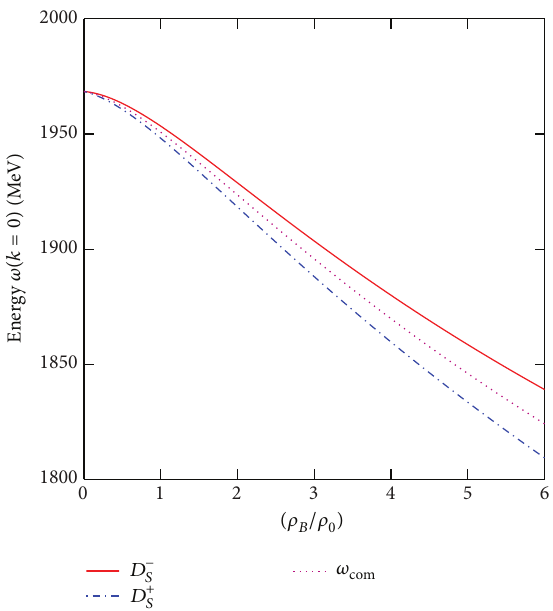
Figure 3: 𝐷 𝑆 meson mass degeneracy breaking in hyperonic matter, as a function of baryonic density, for typical values of the other parameters ( 𝑇 = 100 MeV, 𝑓 𝑠 = 0.5 , and 𝜂 = 0.5 ). The medium masses of 𝐷 + 𝑆 and 𝐷 − 𝑆 are observed to fall symmetrically about 𝜔 ( see text